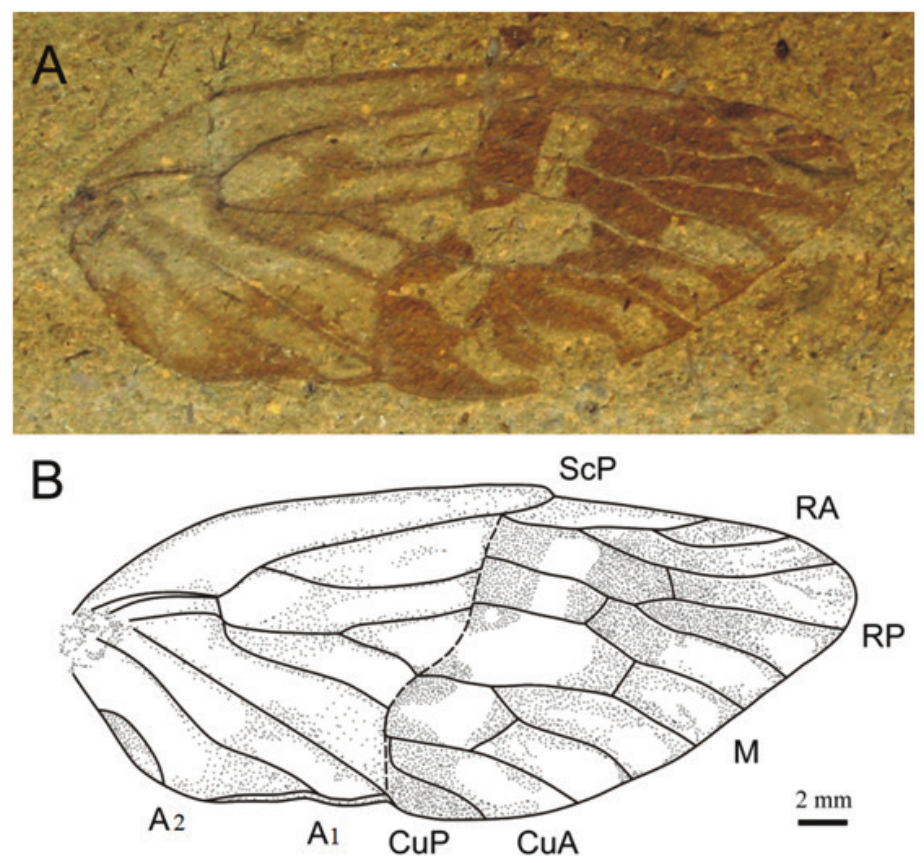
Figure 1. Holotype of Maculaprosbole zhengi gen. et sp. n. A Photograph B Line